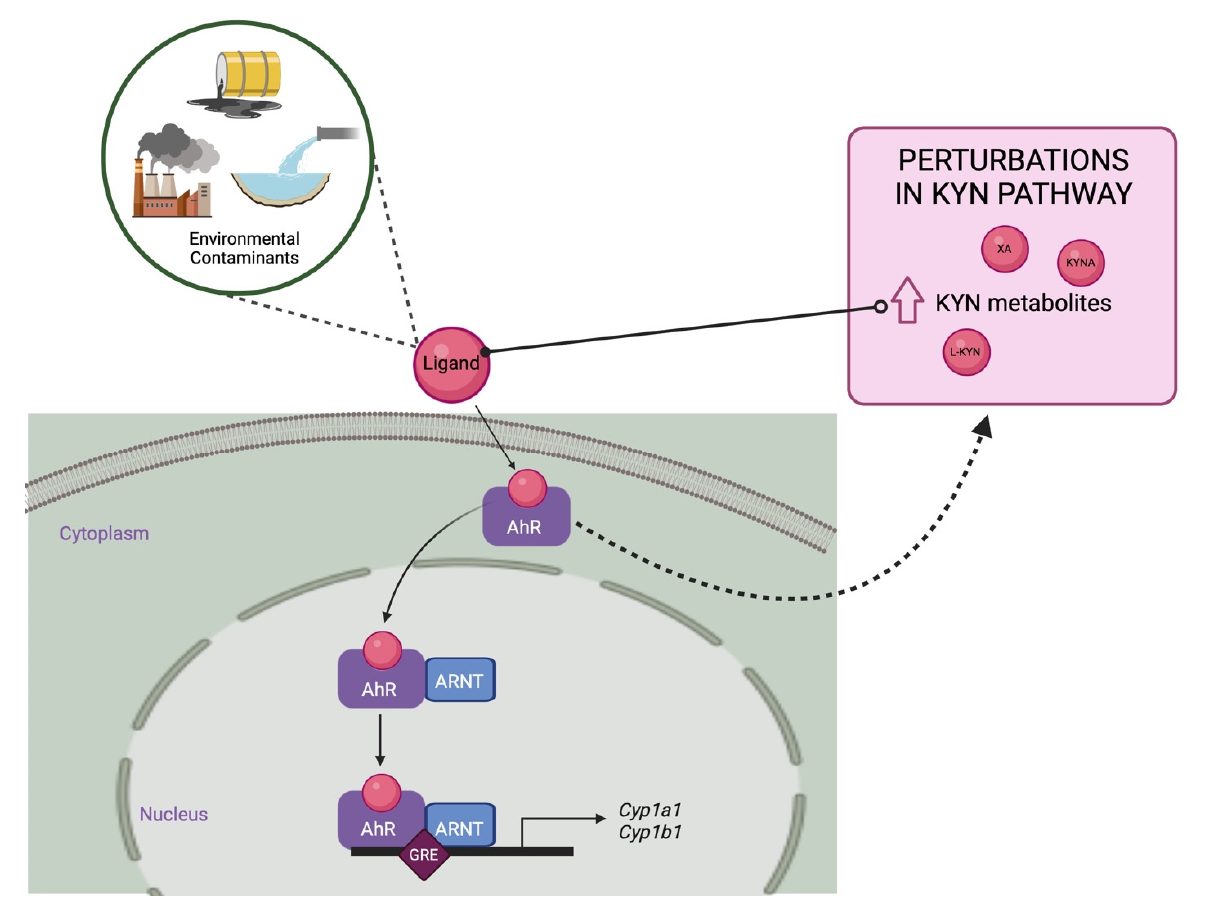
Figure 6. Alterations in TRP metabolism and KYN metabolites may be an indication of exposure to environmental contaminants. Many environmental contaminants (i.e., PACs) are known to act as AhR ligands and are also known to regulate IDO and TDO expression, thereby affecting the production of immunomodulatory KYN metabolites. Moreover, many of these metabolites can also act as AhR ligands and induce AhR target genes. Figure created on biorender.com.